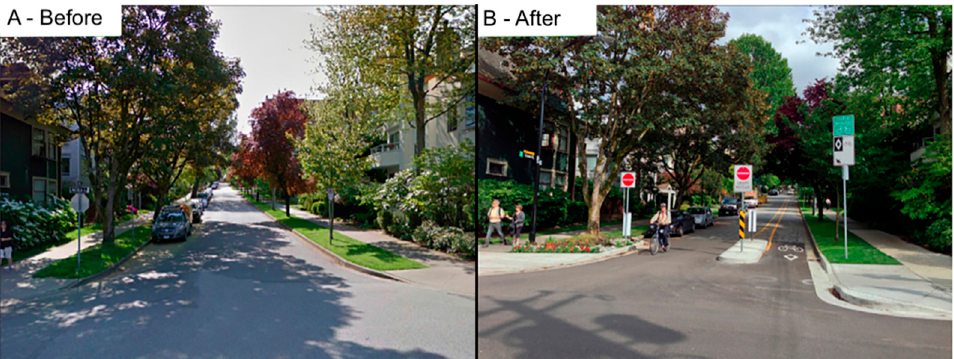
Figure 7. The Comox-Helmcken streetscape before ( A ) and after ( B ) greenway construction. Photo A: Google Street View; Photo B: Reproduced with permission from Paul Krueger, City of Vancouver